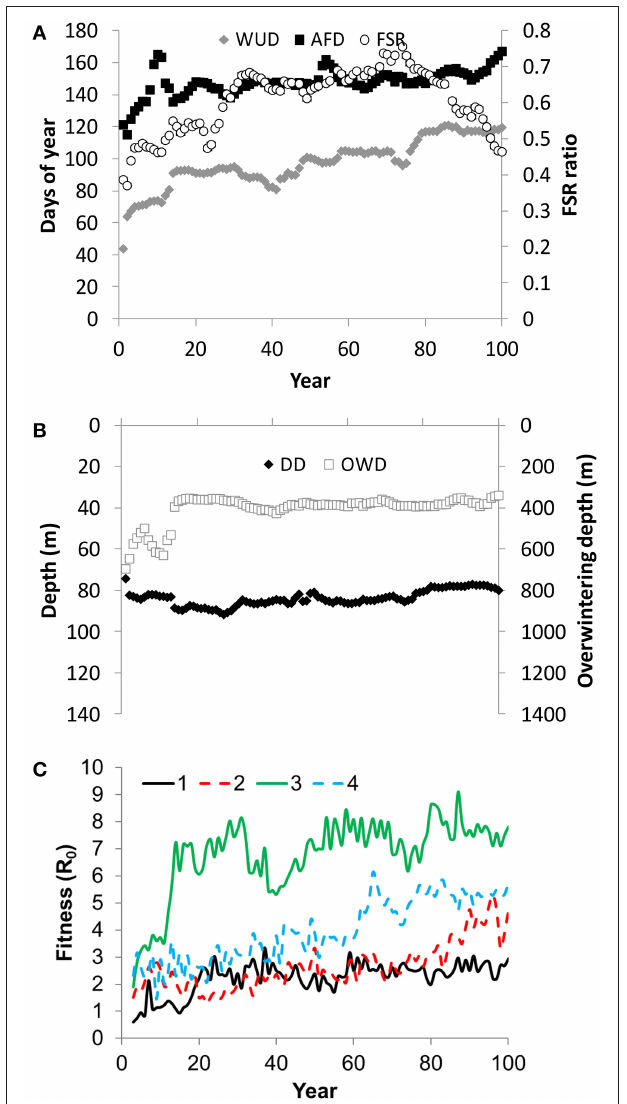
FIGURE 8 | The development over 100 years of the best replicate in simulation 6 in (A) wake up day (WUD), allocation to fat day (AFD) and fat to soma ratio (FSR) traits, (B) the day depth (DD) and overwintering depth (OWD), and (C ) fitness (the net reproductive rate, R0) of all four replicates. Values are from end of each